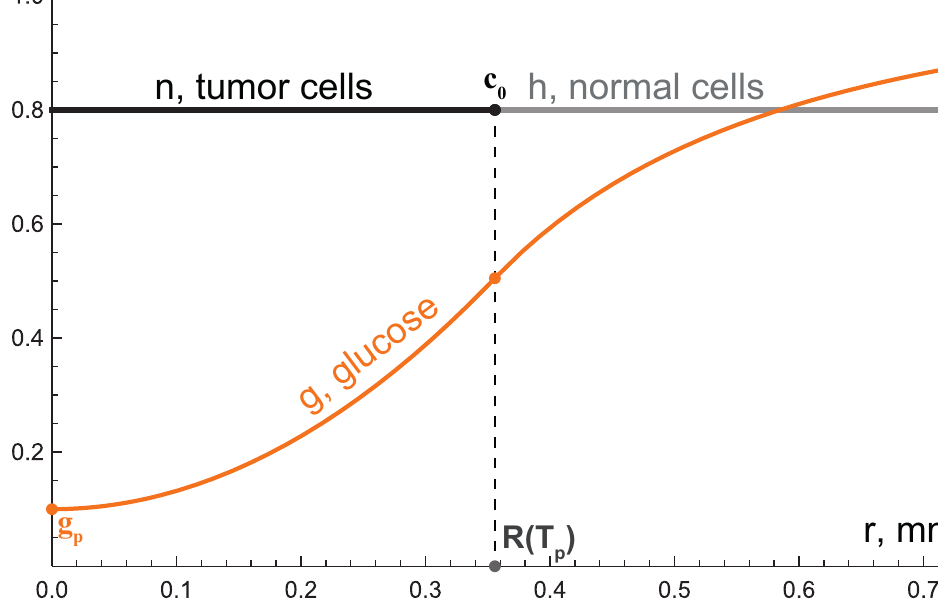
Figure 2. The distributions of the variables of the tumor growth model, governed by the system of Equation (6), at the moment when first quiescent tumor cells have just begun to appear. Prior to this moment, all tumor cells were constantly